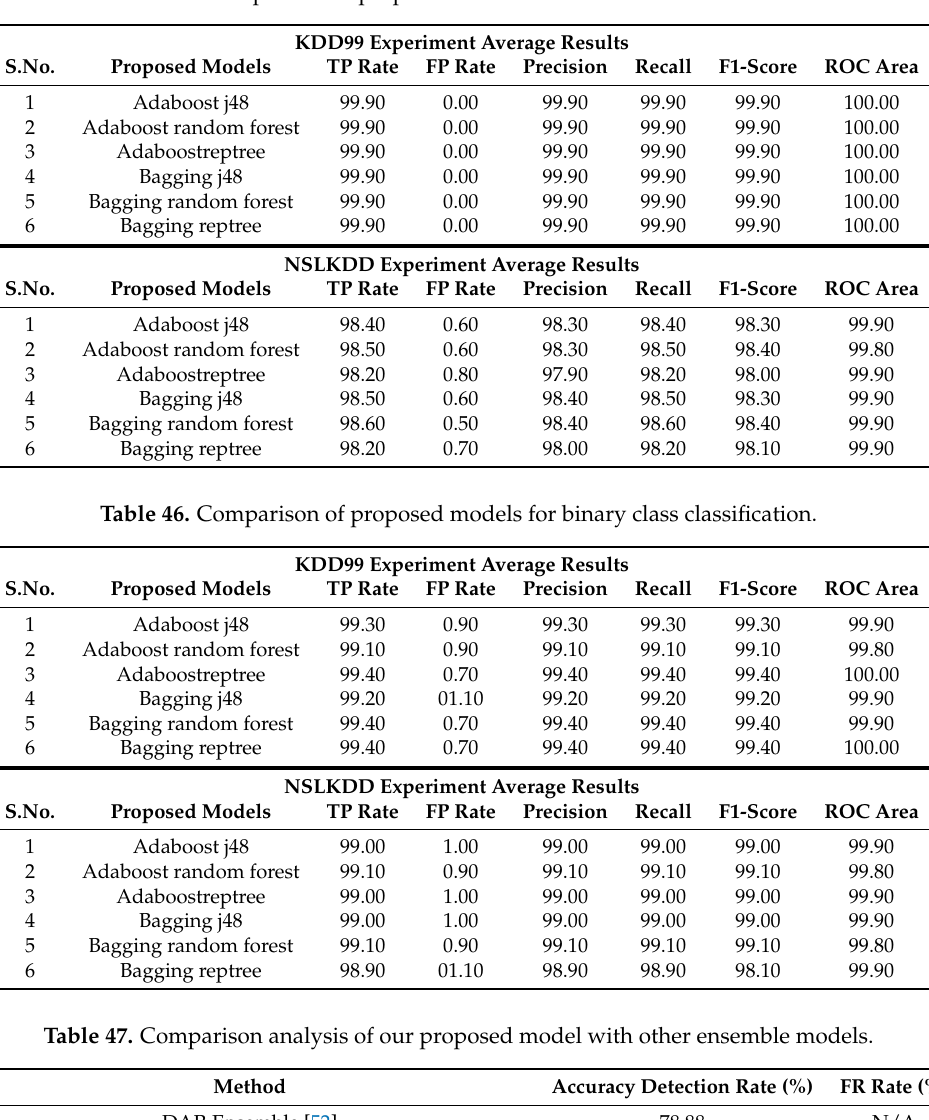
Table 45. Comparison of proposed models for multiclass classification.